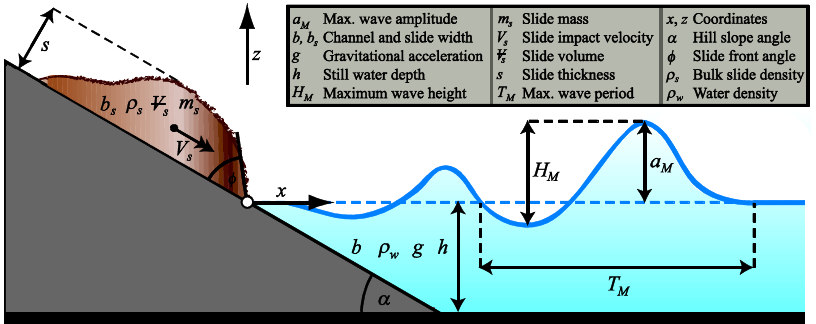
Figure 1. Definition sketch of subaerial landslide tsunami (impulse wave) generation (adapted from Heller and Hager [26], with permission from © 2010 American Society of Civil